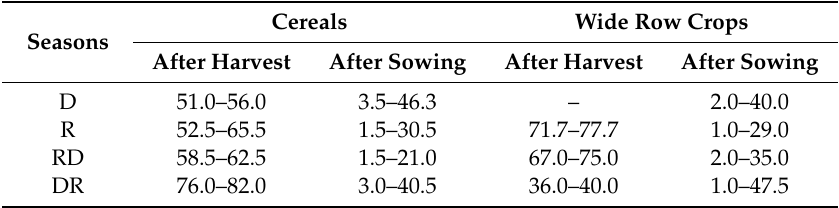
Table 1. Cover ratio in soil surface after crop harvest and sowing. Cereals Wide Row Crops Seasons After Harvest After Sowing After Harvest After